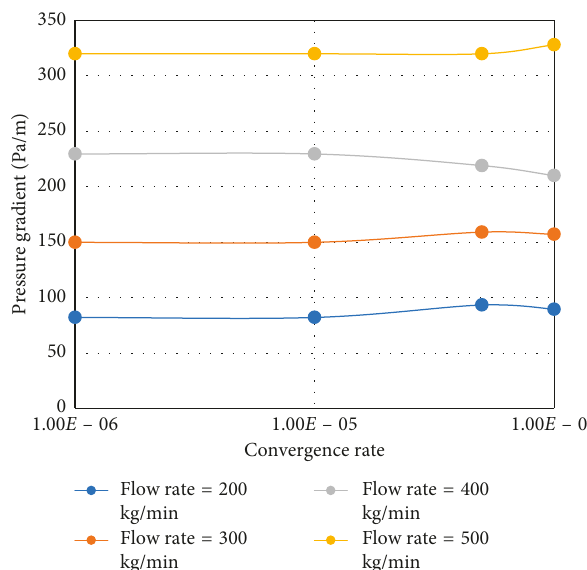
Figure 6: An example of optimum convergence rate analysis.